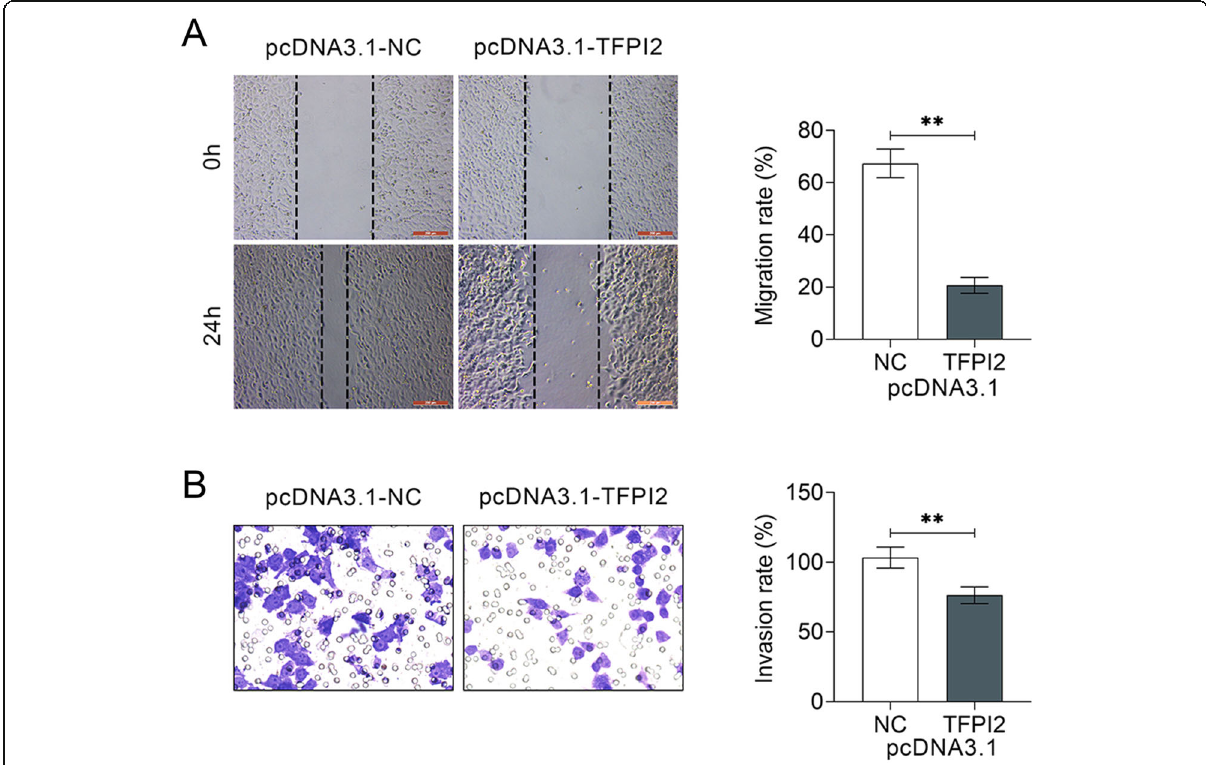
Fig. 3 Over-expression of TFPI2 suppressed migration and invasion of breast cancer. a Over-expression of TFPI2 inhibited cell migration of MDA- MB-453 cells. ** represents pcDNA 3.1-TFPI2 vs. pcDNA 3.1-NC, p < 0.01. b Over-expression of TFPI2 inhibited cell invasion of MDA-MB-453 cells. ** represents pcDNA 3.1-TFPI2 vs. pcDNA 3.1-NC, p <